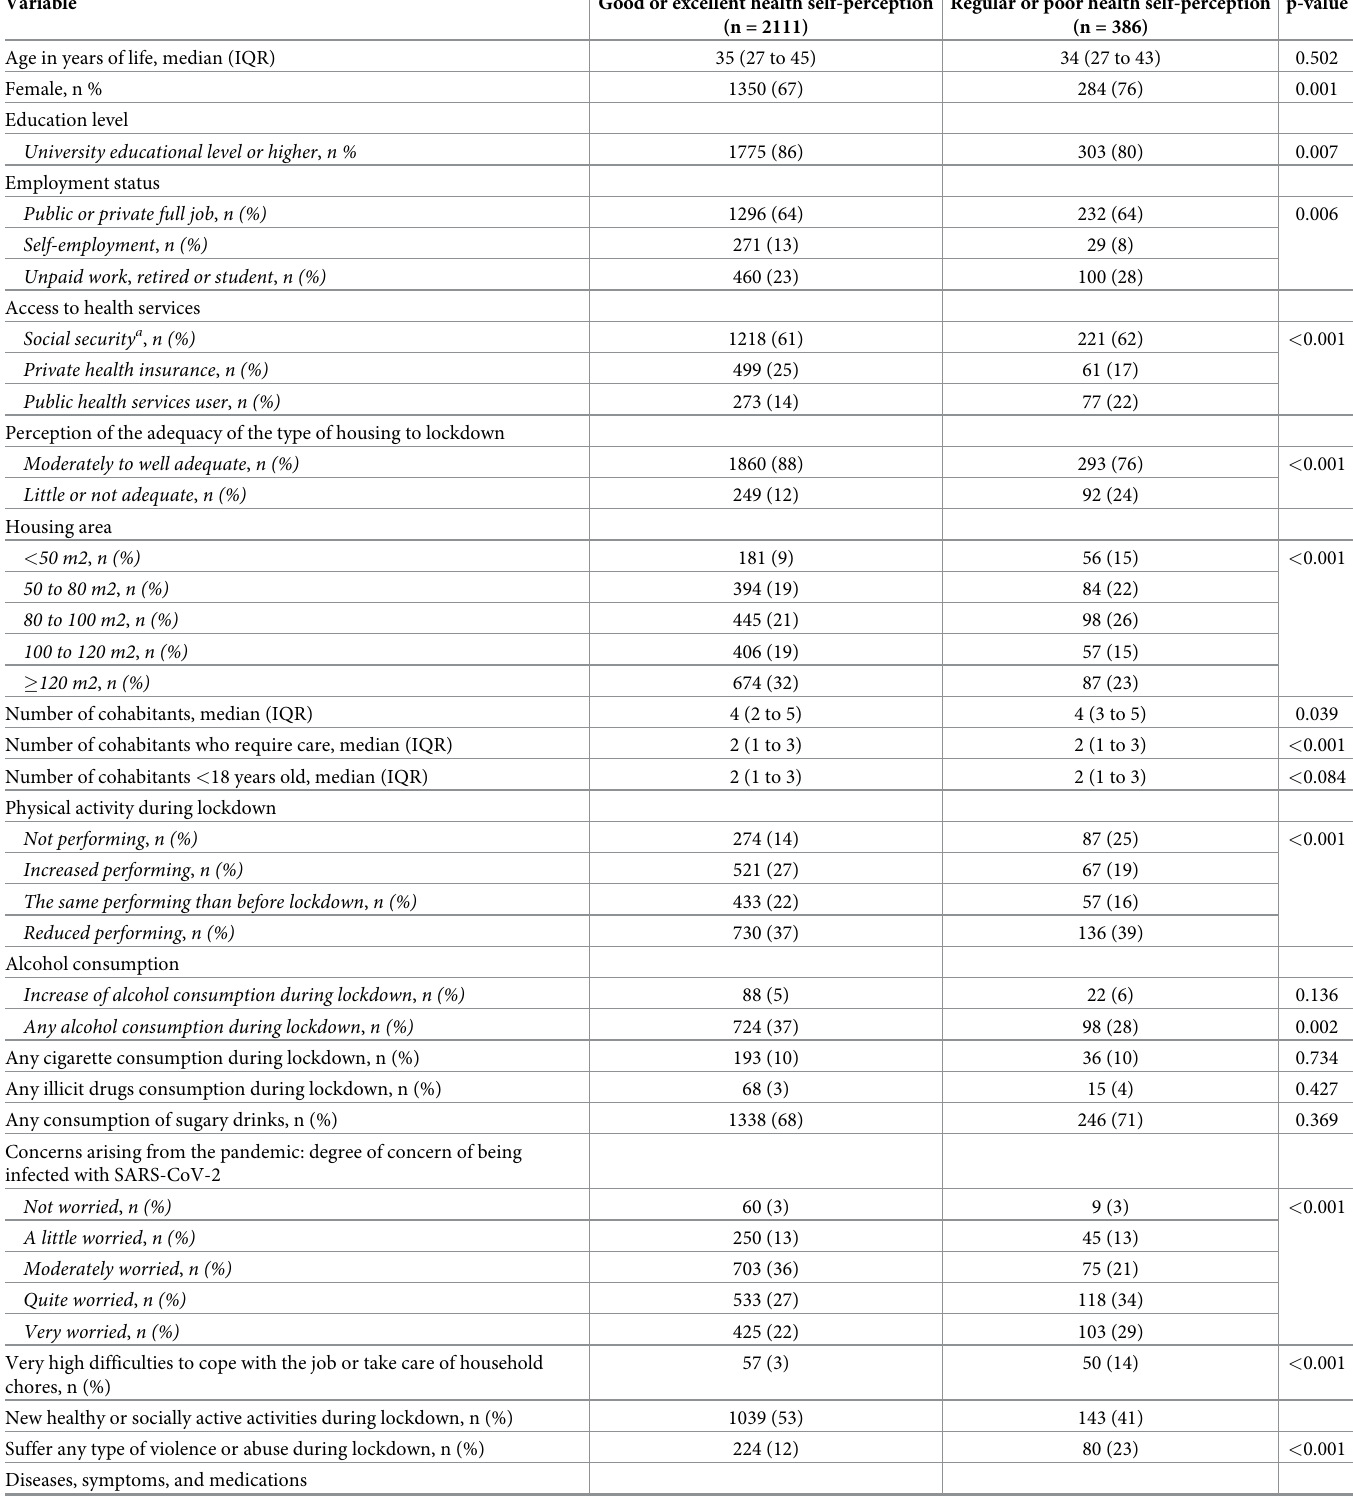
Table 3. Differences in characteristics across health self-perception